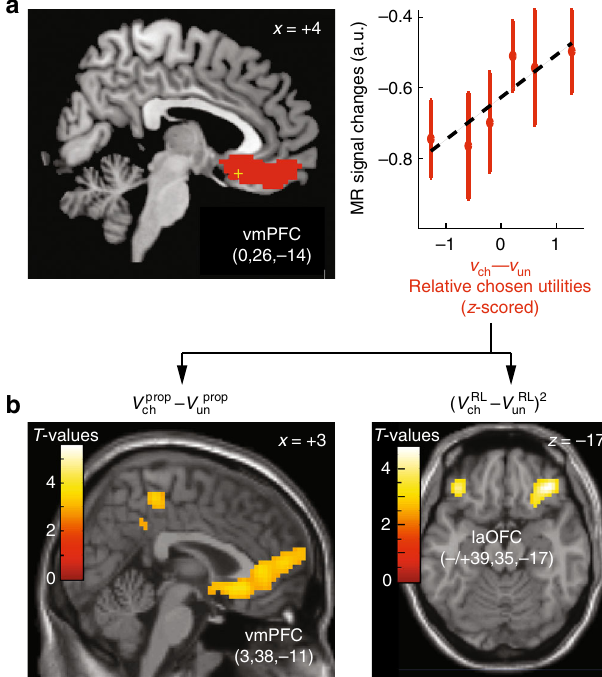
Fig. 8 Prefrontal activations associated with value components of normalised utilities. a, left: topography of fMRI activations positively correlated with relative chosen normalised utilities v ch − v un (red) from Model MIX (no other PFC activations exhibited this effect) and superimposed on sagittal anatomical slice X = + 4 (MNI template, see Supplementary Table 4 for MNI-coordinates of activation peaks: yellow cross; results from the second regression analysis). a, right: MR signal changes averaged over the cluster shown on the left and plotted against relative chosen normalised utilities v ch – v un , z -scored within participants. Error bars are s.e.m. across participants ( N = 21). b When normalised